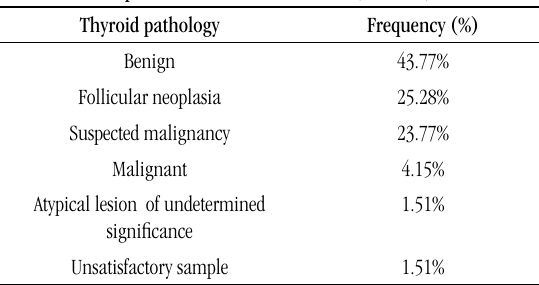
tABLE 1 – Frequency of thyroid pathologies in patients who underwent FNA ( n =